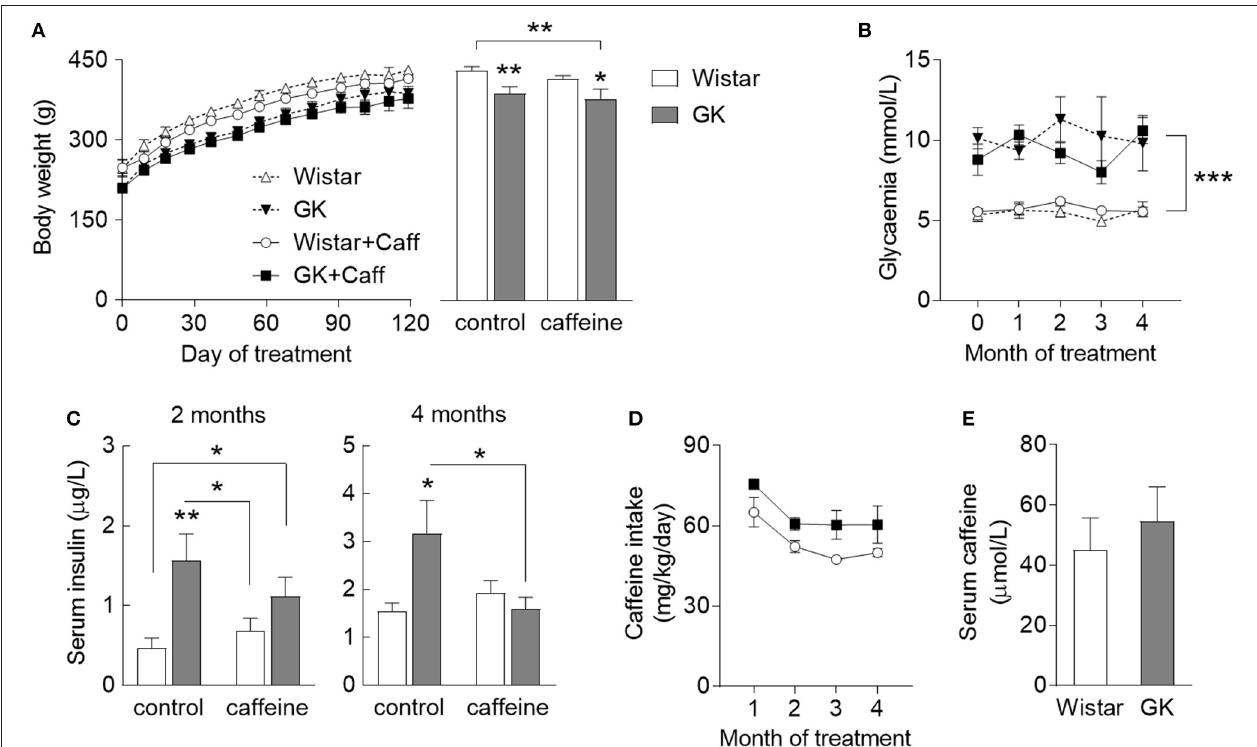
FIGURE 1 | Characteristics of diabetic GK rats (filed symbols/bars) and control Wistar rats (open symbols/bars), namely body weight (A) across the caffeine treatment period (line graph) and at the end of the study (bar graph), glycaemia (B) , concentration in the serum insulin determined after 2 and 4 months of treatment (C) , caffeine intake measured across the treatment period (D) , and concentration of serum caffeine after 4 months of caffeine exposure (E) . Caffeine (1 g/L) was provided through the drinking water for 4 months, starting at 2 months of age. Data are mean ± SEM of 8 rats per group. Symbols represent LSD test results after ANOVA with either significant diabetes effect or significant diabetes-caffeine interaction: * P < 0.05, ** P < 0.01, *** P < 0.001 for GK vs. Wistar in the respective treatment group or as indicated.